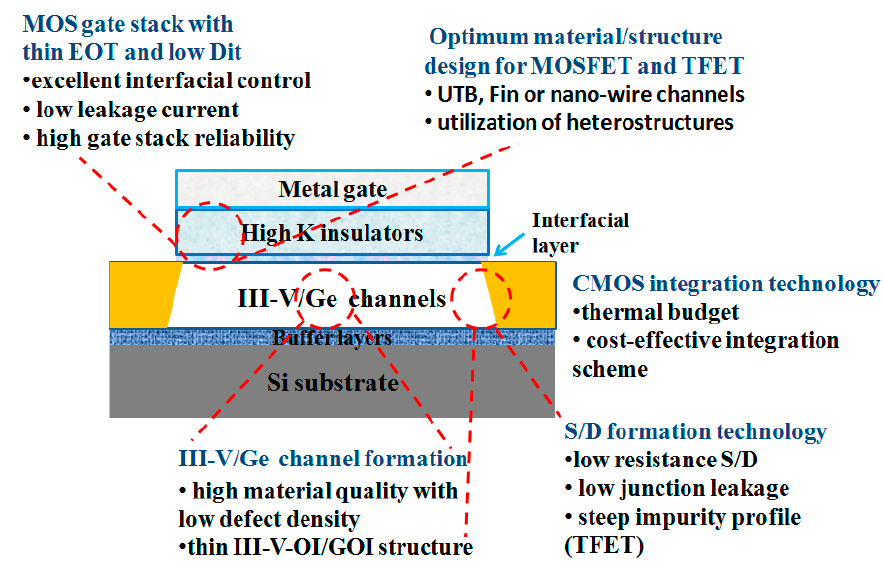
Figure 50. Critical issues of Ge/III-V integration with Si CMOS platform [344].